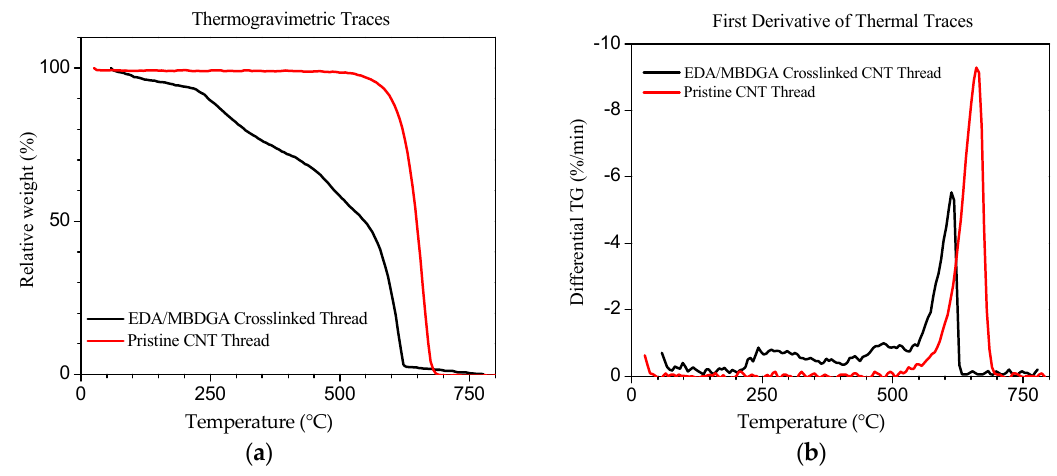
Figure 8. TGA curves of pristine MWCNT thread and EDA/MBDGA cross-linked MWCNT thread. ( a )Thermogravimetric traces; ( b ) First derivative of thermal traces. Table 1. Electrical conductivity of MWCNT threads.